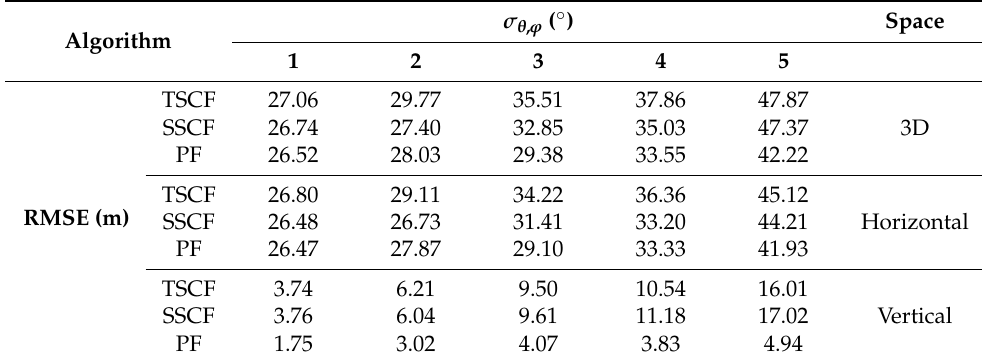
Figure 9. Performance comparison of the batch-processing solutions with certain UAS positions and using 51 measurement points. Table 2. RMSE results of the batch-processing solutions with certain UAS positions and using 51 measurement points.